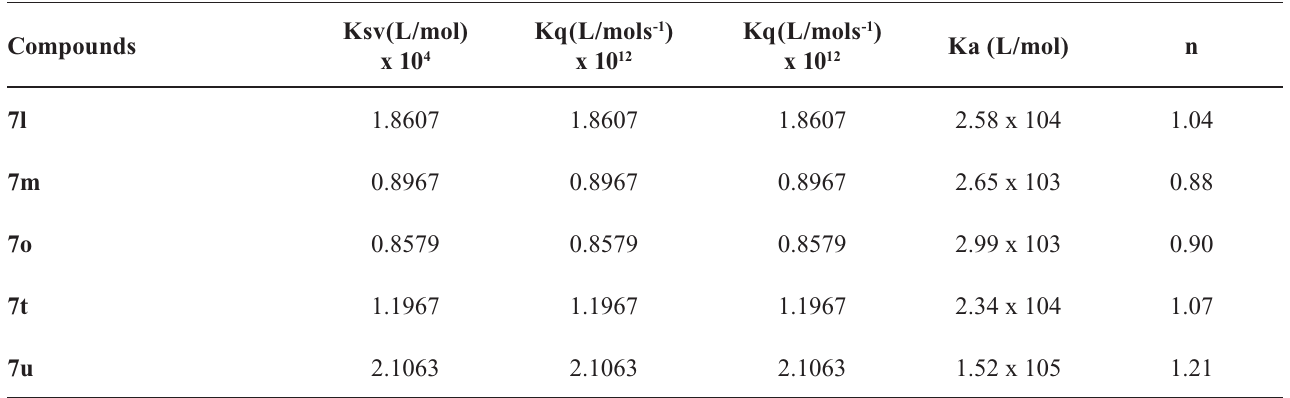
TABLE V - Binding constant and number of binding site of compounds warfarin and ibuprofen with BSA at 298K